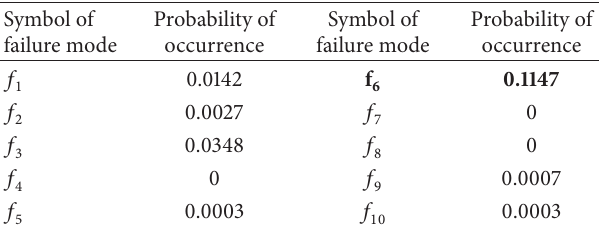
Table4:DiagnosisresultofstaticfaultdiagnosismechanisminCase